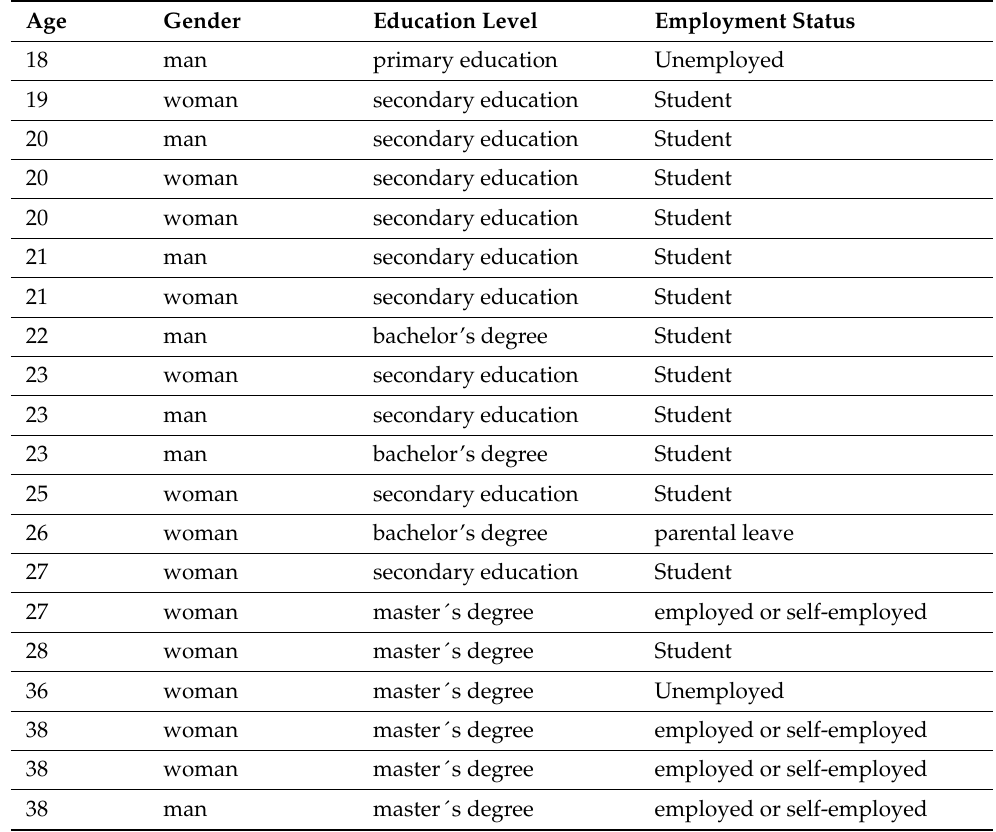
Table 1. Description of